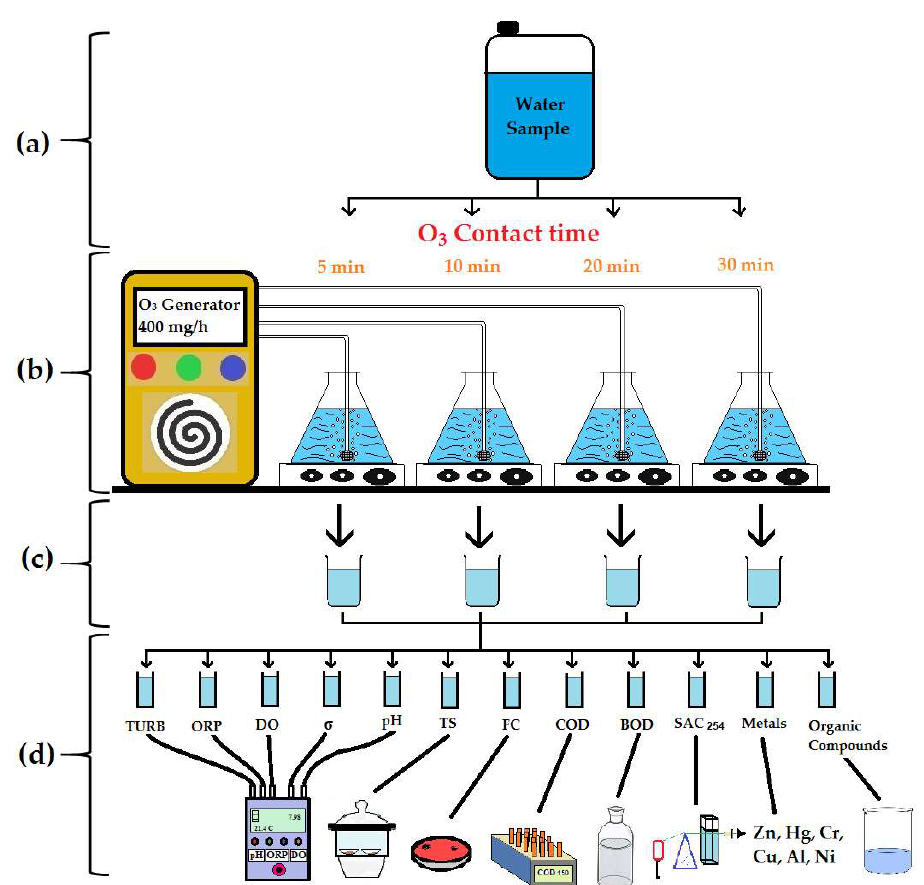
Figure 2. Scheme of the experimental process. ( a ) Water sampling from the study area, ( b ) Ozonation of aliquots at different times, ( c ) Sampling of aliquots and ( d ) Measurement of physicochemical parameters.